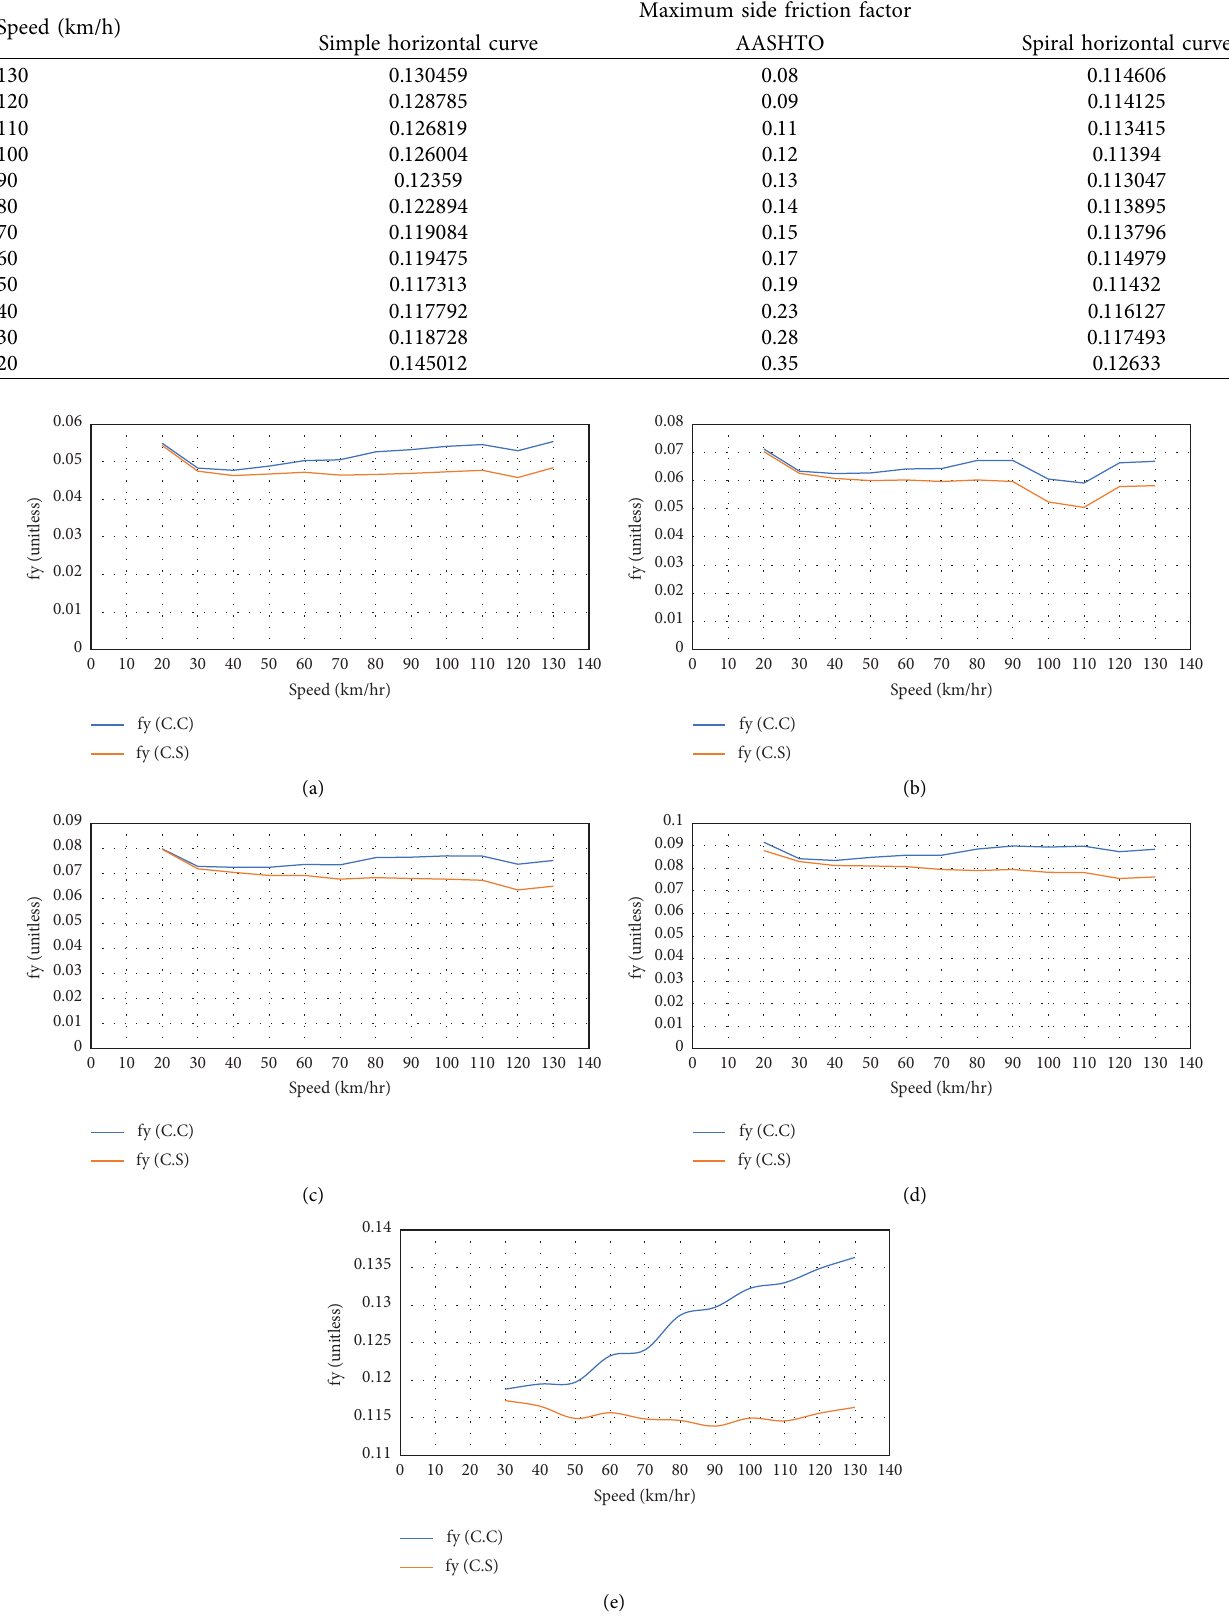
Figure 18: Comparison of the maximum side friction factor for SUV versus the speed in simple and spiral horizontal curves in the radii: (a) 1.3 R, (b) 1.1R, (c) R, (d) 0.9R, and (e)